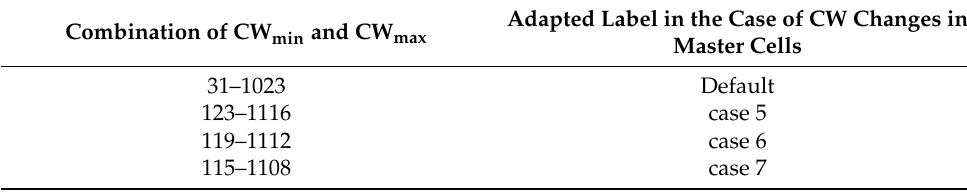
Table 9. Label adaptation of CW combinations in master cells. Combination of CW min and CW max